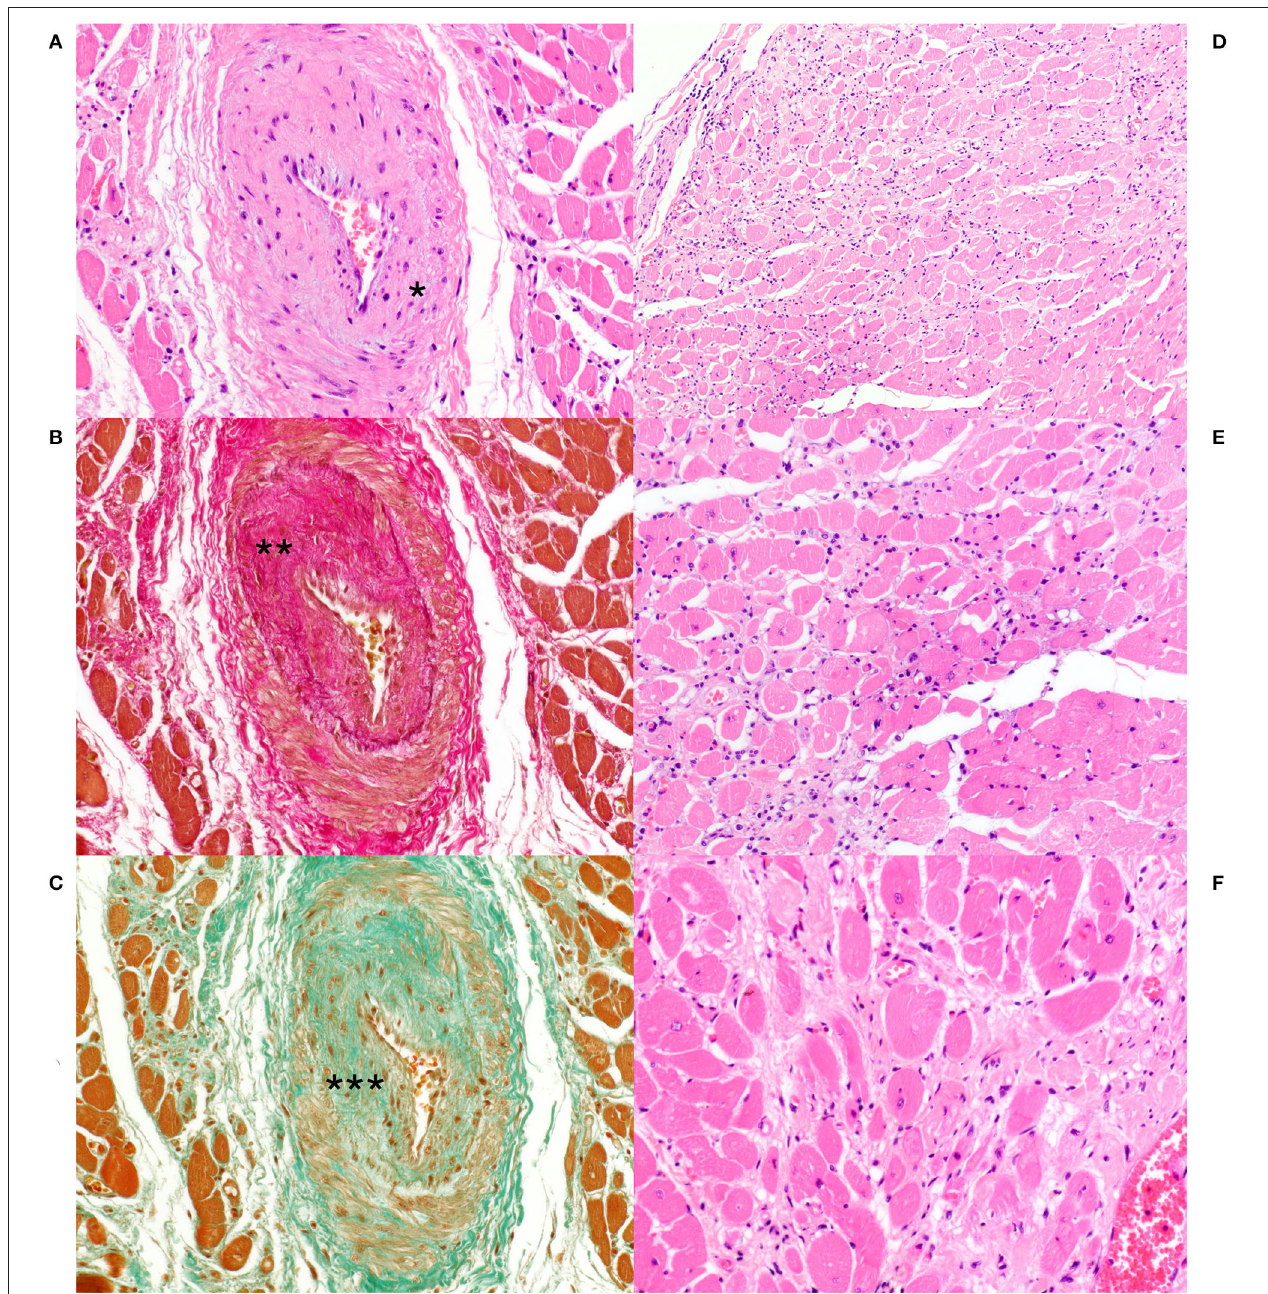
FIGURE 7 | Heart, Eurasian lynx ( Lynx lynx carpathicus ); (A) case 3, H&E stain: Marked thickening of the arterial wall with reduction of the vascular lumen. Multifocal, mild amount of mucin-like material is observed within the intima and at the interface between the Tunica media and adventitia (Asterisk); (B) case 3, Van Gieson stain: marked intimal thickening secondary to deposition of collagen fibers (Asterisks) with segmental loss of the internal elastic lamina; (C) Case 3, Masson’s trichrome stain: Presence of several myointimal cells within the thickened intimal layer (Asterisks); (D) case 3, H&E stain: multifocal interstitial fibrosis with reduction and replacement of the myofibers; (E) case 3 and (F) case 4, H&E stain: Myocytes with marked pleomorphism (i.e., variable morphology) and variable compression and distortion by the surrounding connective tissue. Occasional vacuolization of the sarcoplasm along with clear spaces rimming the myocyte profile. Mild to moderate hypercellularity in the